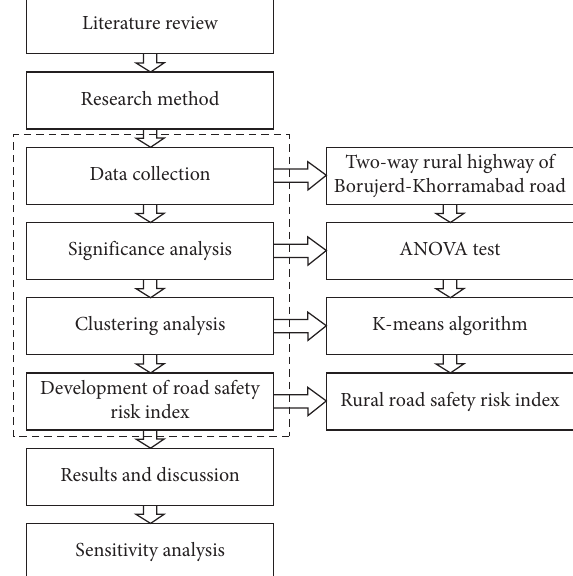
Figure 1: The proposed